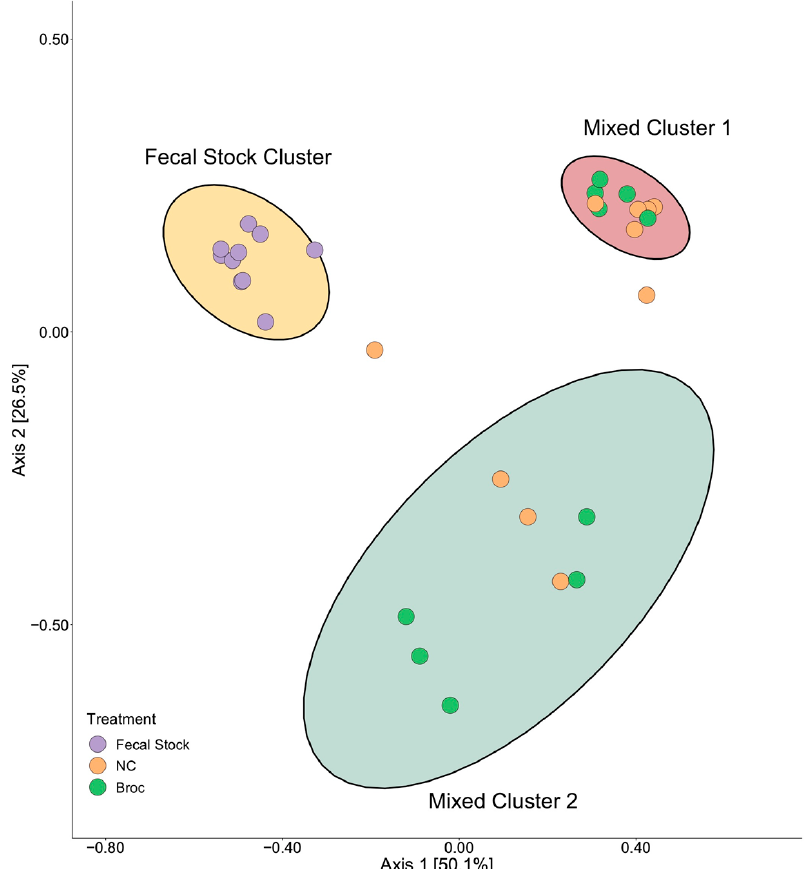
Figure 2. Principal coordinate analysis (PCoA) showing beta-diversity of samples. Each point represents one sample, with the color of the point indicating if it is a pre-incubation fecal stock or post-incubation fecal culture treated with in vitro digested broccoli (Broc), or a negative control (NC) in vitro digest. Clusters, indicated by colored ellipses, were verified by k-means clustering and the number of clusters selected by the elbow